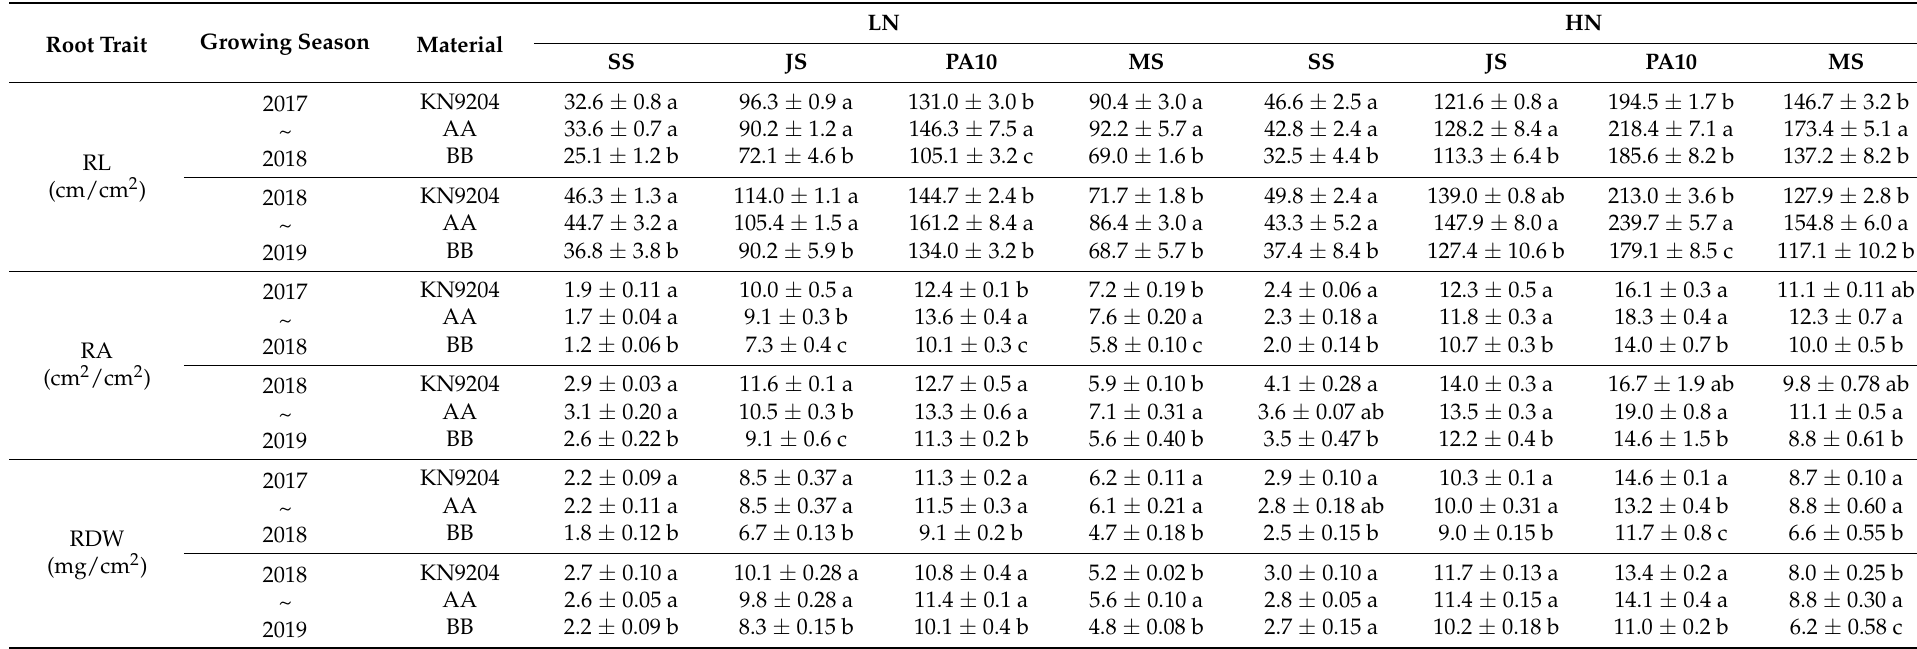
Table 1. The RL, RA and RDW of KN9204 and the QMrl - 7B NILs in different growing